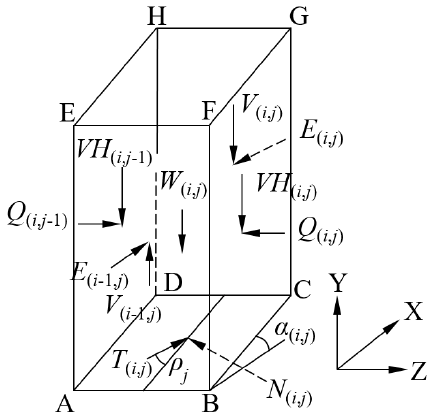
Figure 2. Meshing grid of sliding mass with coordinate system.